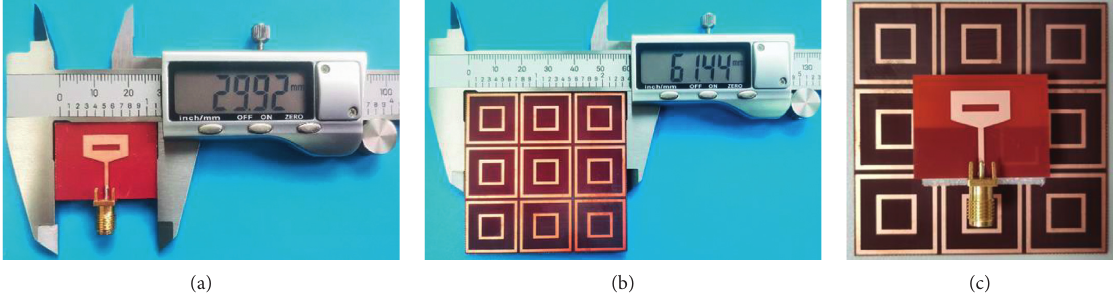
Figure 4: Photographs of the antenna system: (a) monopole antenna, (b) AMC surface, and (c) assembled antenna system.